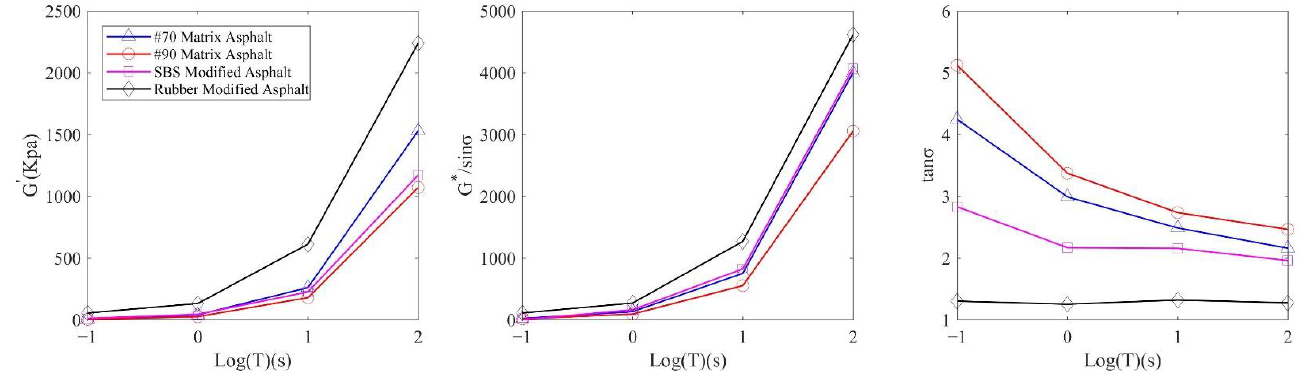
Figure 6. The variation of rheological parameters at the same temperature but different frequencies.